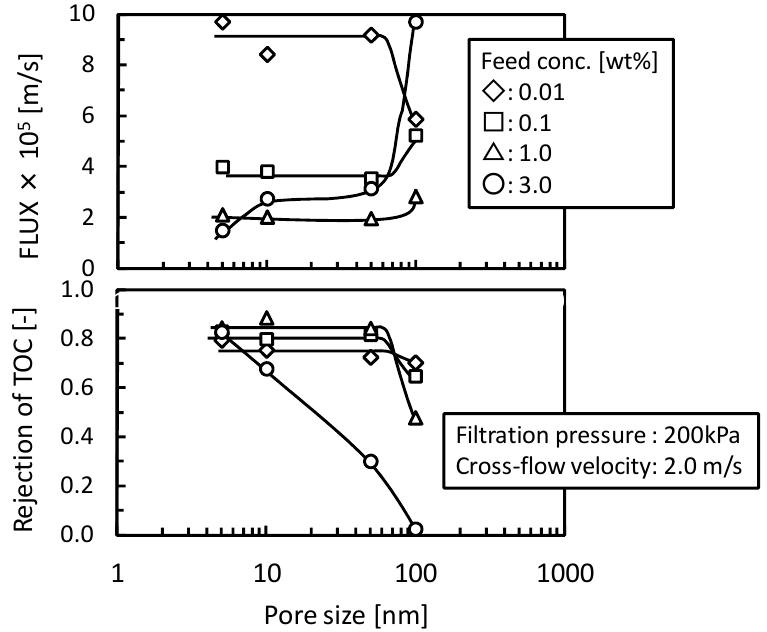
Figure 4. Effects of the feed concentration on flux and the rejection of TOC component of UF and microfiltration (MF) membranes as functions of nominal pore